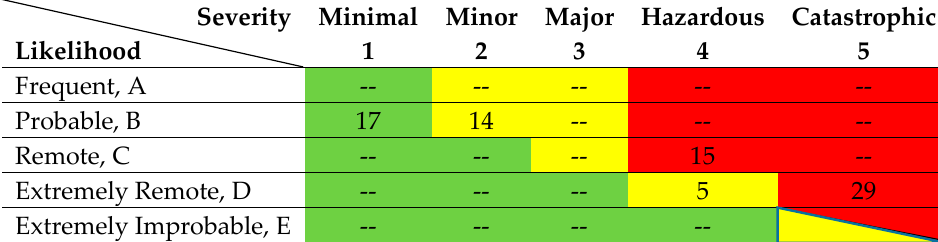
Table 12. Risk matrix with look-ahead time 120 s, head-to-head scenario. Table 12 . Risk matrix with look-ahead time 120 s, head-to-head scenario.